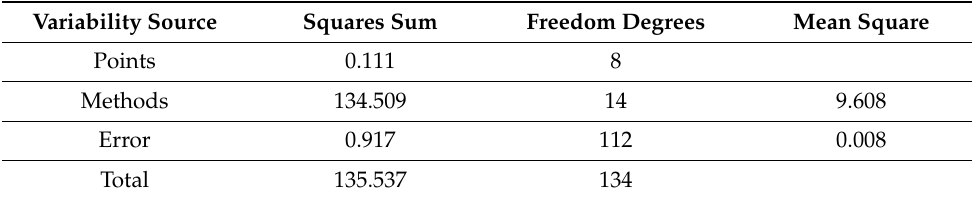
Table 4. Analysis of